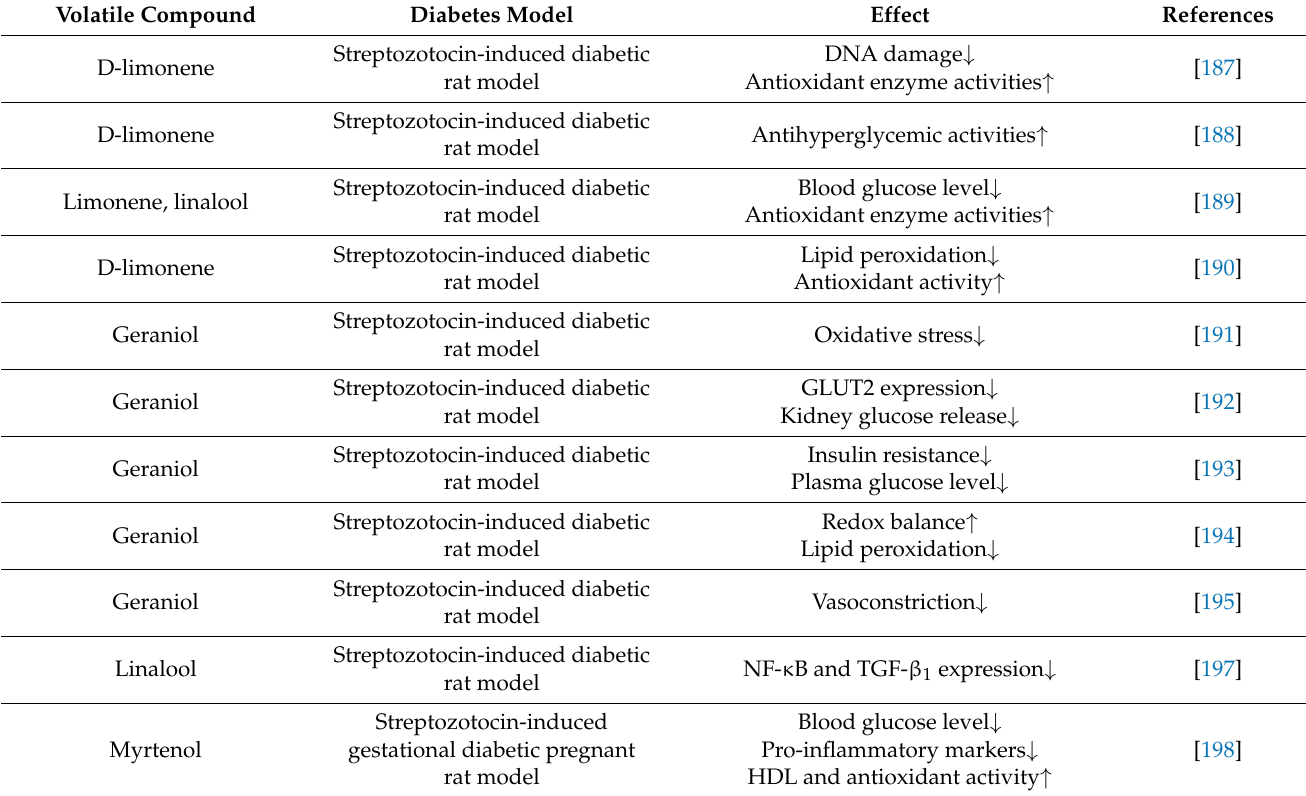
Table 5. The effect of volatile compounds rich in berries on diabete